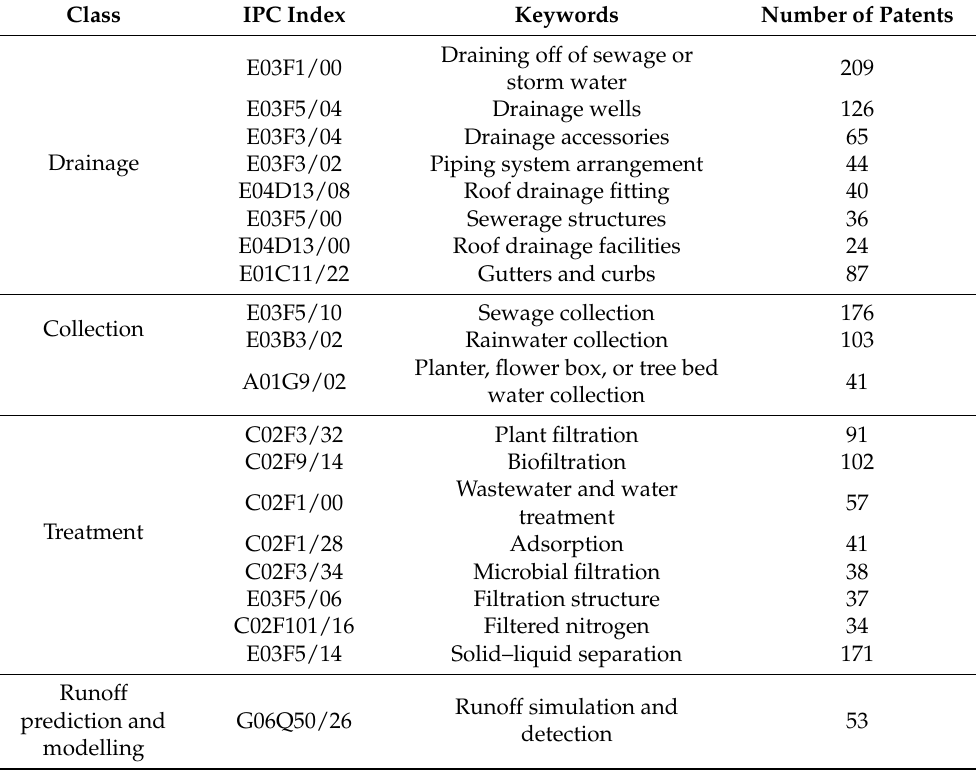
Table 3. Top 20 keywords in classified